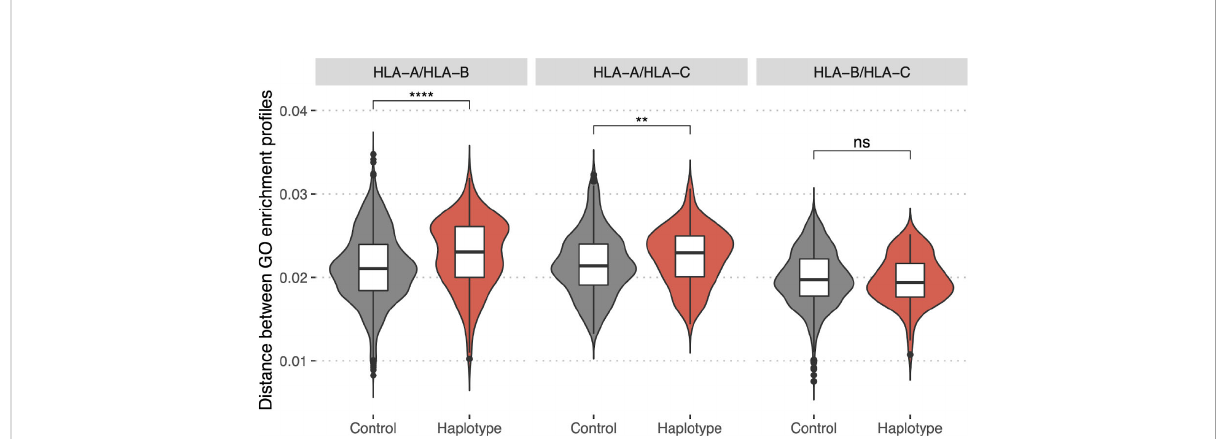
FIGURE 7 Bias in HLA presentation of proteins with different molecular functions is compensated in HLA-A/HLA-B and HLA-A/HLA-C haplotypes. Distance in GO category pro fi les between pairs of HLA alleles of different genes (HLA-A and HLA-B, left panel; HLA-A and HLA-C, central panel; HLA-B and HLA-C, right panel). “ Haplotype ” set is composed of pairs of alleles constituting haplotypes with high frequency in one of the populations, “ Control ” is composed of random pairs of alleles from the “ Haplotype ” set (for details see Methods section). Statistically signi fi cant differences between the groups are for HLA-A/HLA-B (p-value = 5e-07, Mann – Whitney U-test) and HLA-A/HLA-C genes (p-value = 0.004, Mann – Whitney U-test). Higher values of the distance for “ Haplotype ” group indicate that pairs of alleles composing frequent haplotypes tend to present proteins with distinct functions. (**** P ≤ 0.0001; ** P ≤ 0.01; ns, not signi fi